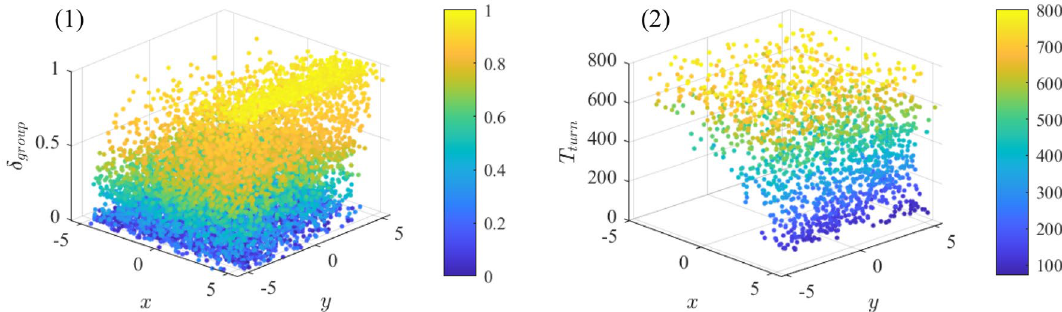
Figure 3. The responsivity of the BEAR-S model with the single informed individual ( IF num = 1 , c b = 20 ). (1) Response accuracy δ group . (2) The time cost of response T turn (simulations of the uncompleted response is not drawn).